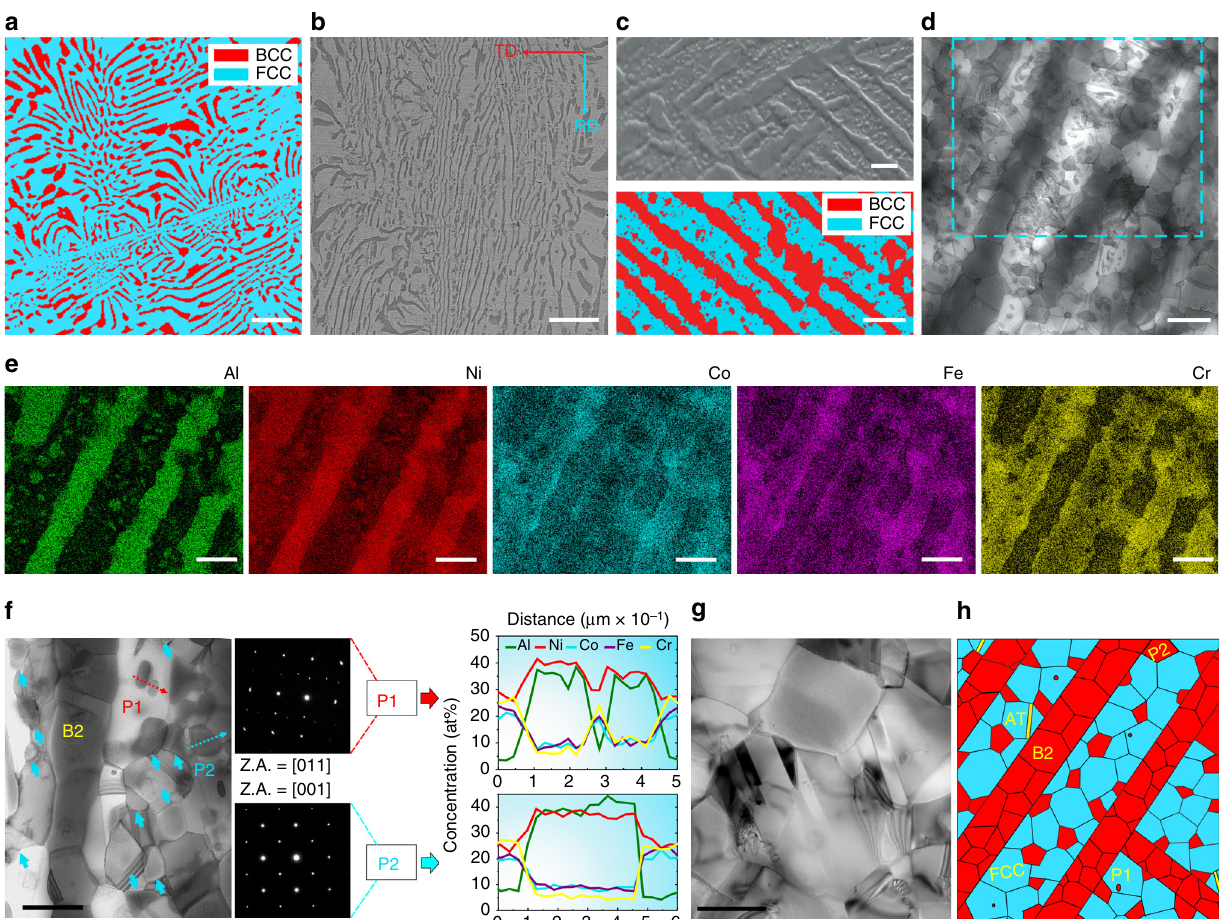
Fig. 1 Microstructures of the as-cast EHEA and the hierarchical DPHL700. a Electron-backscatter-diffraction (EBSD) phase image of the as-cast EHEA. b , c Scanning-electron-microscope (SEM) image, high-magni fi cation SEM image, and EBSD-phase image of the DPHL HEA. RD, rolling direction; TD, transverse direction. d Scanning TEM (STEM) image exhibiting a more detailed DPHL structure. e EDS maps of the identical region marked in d showing the distribution of Al, Ni, Co, Fe, and Cr. f Enlarged STEM image showing the distribution of P2 (the intergranular B2 phase, marked by blue arrows) and P1 (the intragranular B2 phase, marked by red arrow), and the corresponding SADPs and EDS composition pro fi les. g TEM image showing annealing twins. h Microstructural schematic sketch of the DPHL structure. AT, annealing twin. Scale bars, 20 µ m in a , b , 2 µ m in c , 1 µ m in d – f and 500 nm in